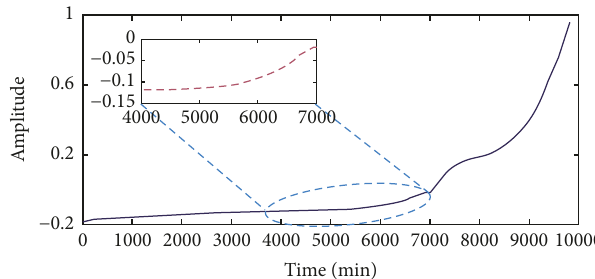
Figure 12: Degradation index constructed by KPCA.